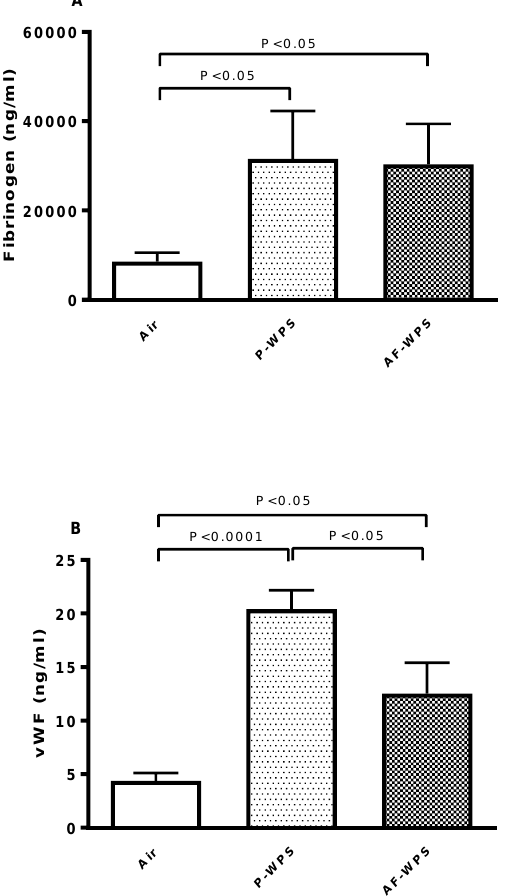
Figure 5. Effects of plain water-pipe smoke (P-WPS) or apple-flavoured (AF)-WPS on plasma concentration of fibrinogen and von Willebrand factor (vWF). Plasma concentrations of fibrinogen ( A ) and von vWF ( B ) at the end of 1 mo exposure period to either air or P-WPS or AF-WPS. Data are mean ± SEM (n = 7–8). Fibrinogen was analysed with Kruskal–Wallis test followed by